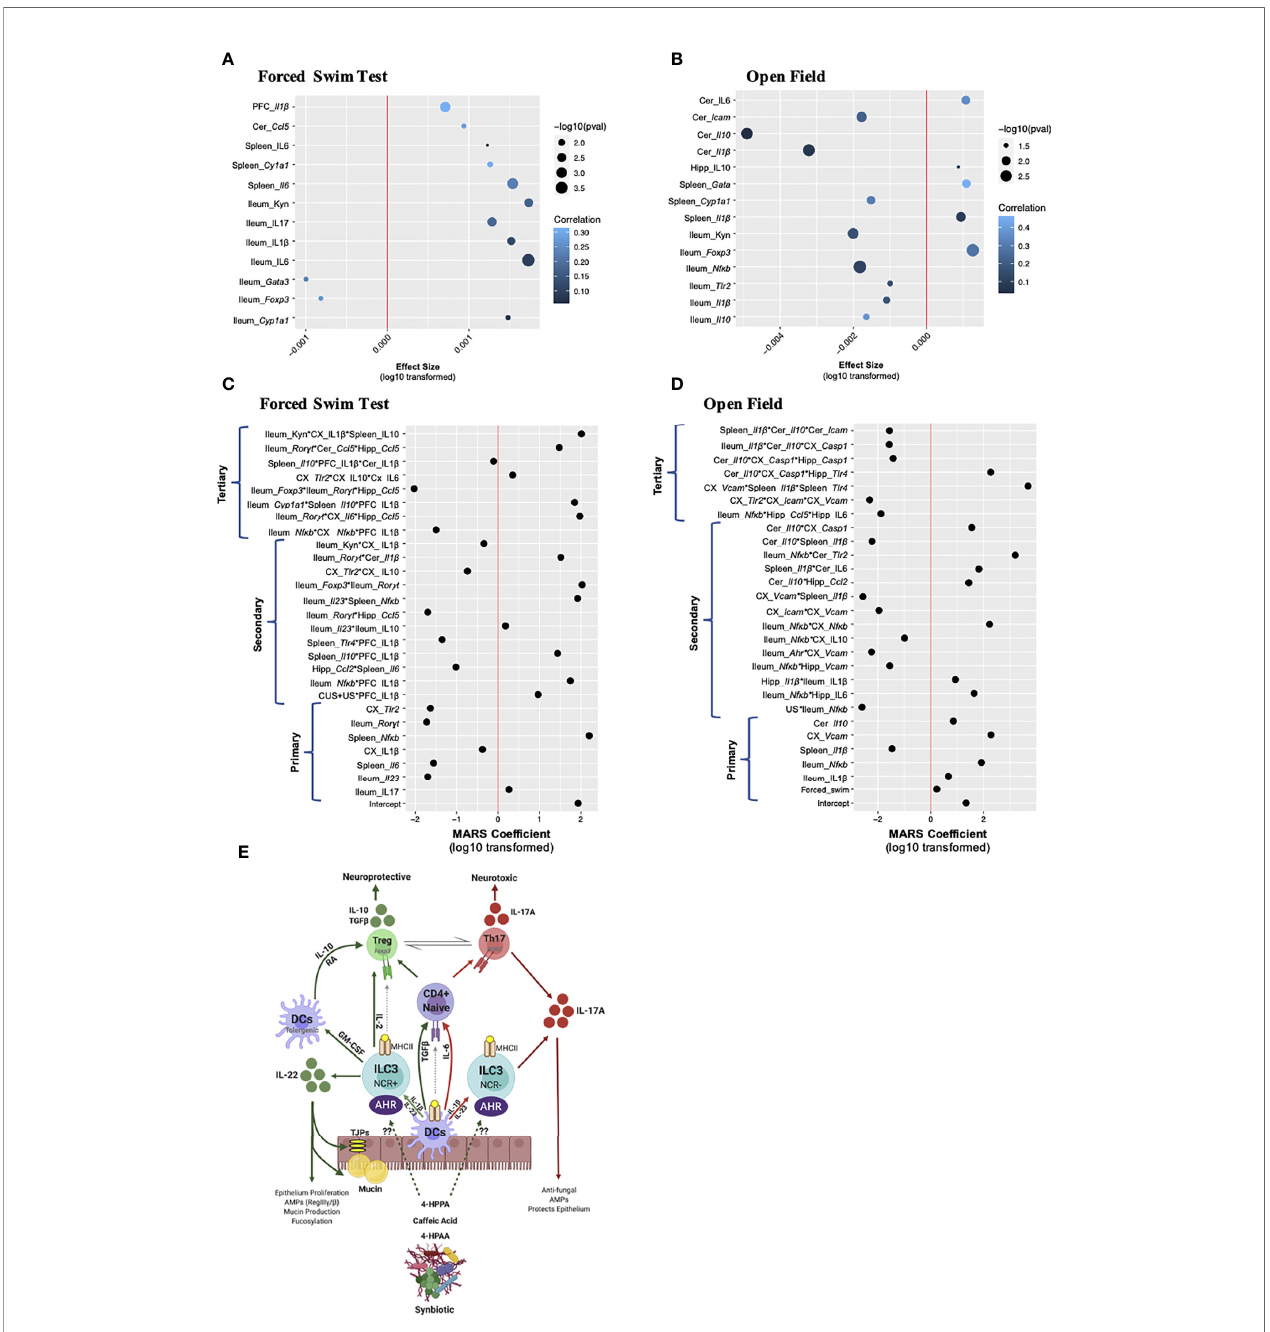
FIGURE 6 | Multivariate analysis of gut-brain-axis coordination towards chronic- and recurrent-stress behavioral predictions. Linear regression modeling in which the individual gene, cytokine, and microbiota were used as response variables, and the behavior was used as the main predictor of interest, while condition, treatment and timepoint were considered covariates. Association to (A) depressive-like behavior and (B) anxiety-like behavior are shown with the x-axis representing the effect size, the y-axis the term and the signi fi cance shown as dot size and correlation (i.e. how well the model fi ts the response variable) as a heatmap. The x-axis represents the absolute value of the response variable log10 transformed, and multiplied by the sign, to establish a normal distribution: i.e. log10(effectsize+1) when the effect size was positive, and log10(abs(effectsize-1))*(-1) when the effect size was negative. A multivariate adaptive regression splines (MARS) model was designed to test the cross-tissue association of gene and cytokine factors (up to tertiary interactions) in the context of predicting (C) depressive-like behaviors and (D) anxiety-like behaviors. The x-axis shows the log10 of the absolute value of the coef fi cient, multiplied by the coef fi cient sign. For both the linear and MARS models, factor names in italics represent mRNA gene expression while normal text is cytokine expression. (E) A working scheme of barrier immunity affected by chronic and recurrent stress and the role of the gut microbiota and its associated metabolites. For all MARS associations, data from the same n = 6 mice were included from the 16S sequencing, RNA, protein and behavioral analyses. DC, dendritic cell; ILC, innate lymphoid cell; NCR, natural cytotoxicity receptor; AHR, aryl hydrocarbon receptor; RA, retinoic